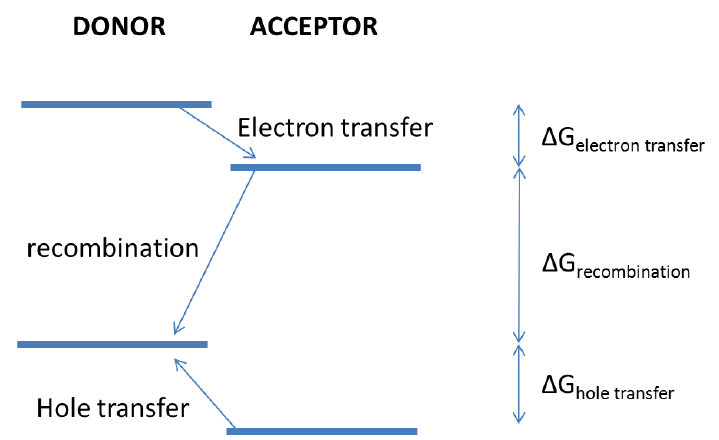
Figure 10. Energy levels associated with donor and acceptor